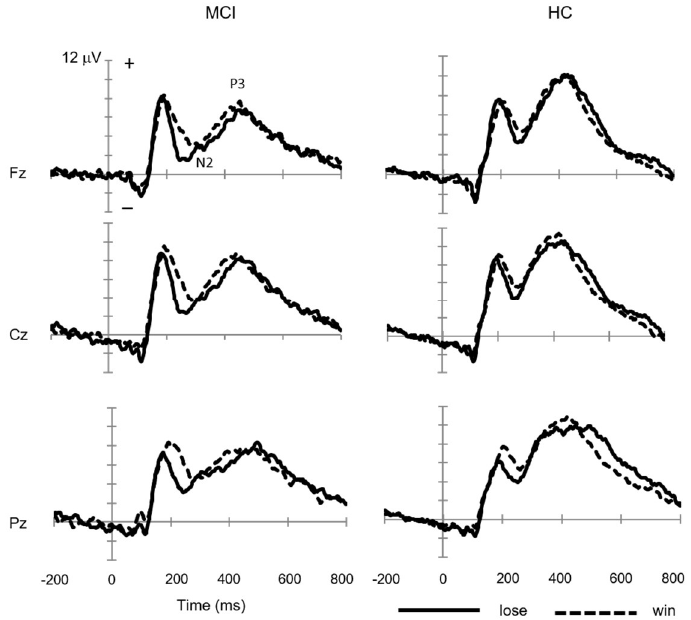
Figure 1. Grand-average waveforms at Fz, Cz, and Pz to feedback stimuli for win and lose trials in mild cognitive impairment (MCI, n = 13) and healthy control (HC, n = 13) groups.